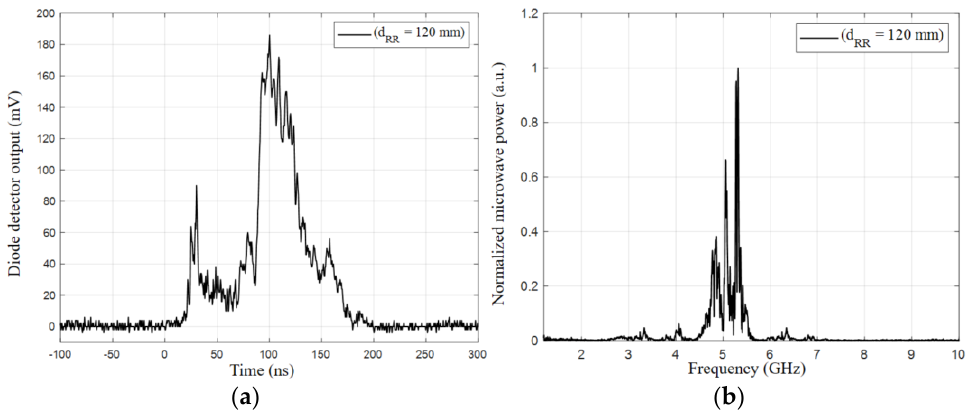
Figure 7. Typical waveform of the axial vircator when d RR = 120 mm: ( a ) diode detector and ( b ) frequency spectrum. Table 3. Experimental results on the optimum diameter of the hole in the ring reflector.